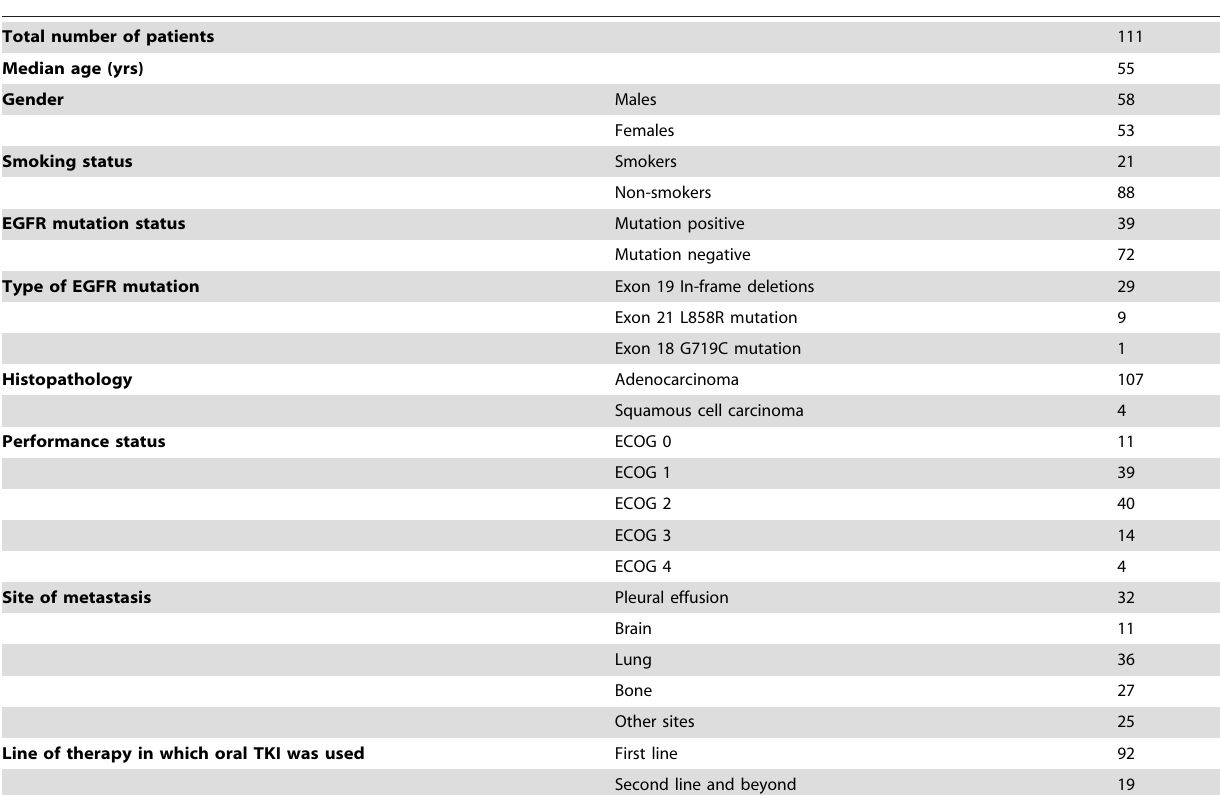
Table 1. Patient demographics, clinical characteristics and details of EGFR mutation.